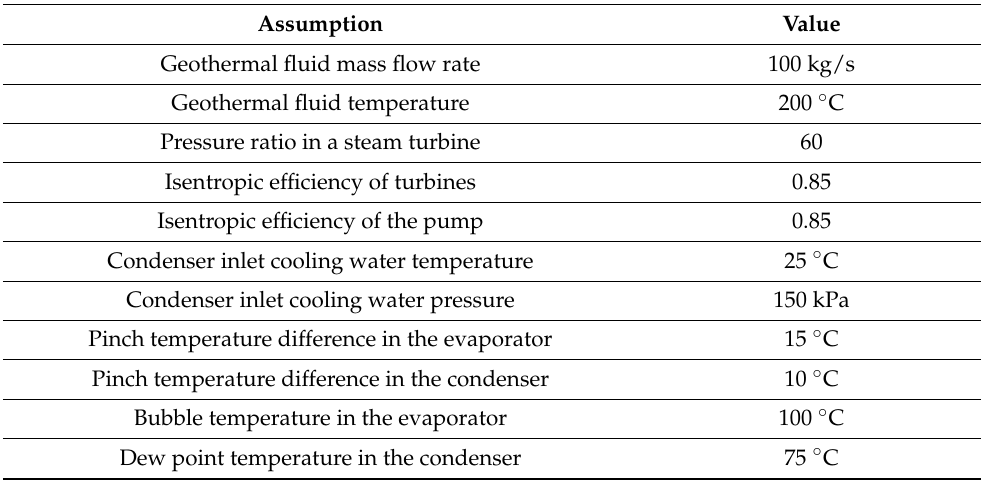
Table 2. Some assumptions and information used in system analysis [27–29].